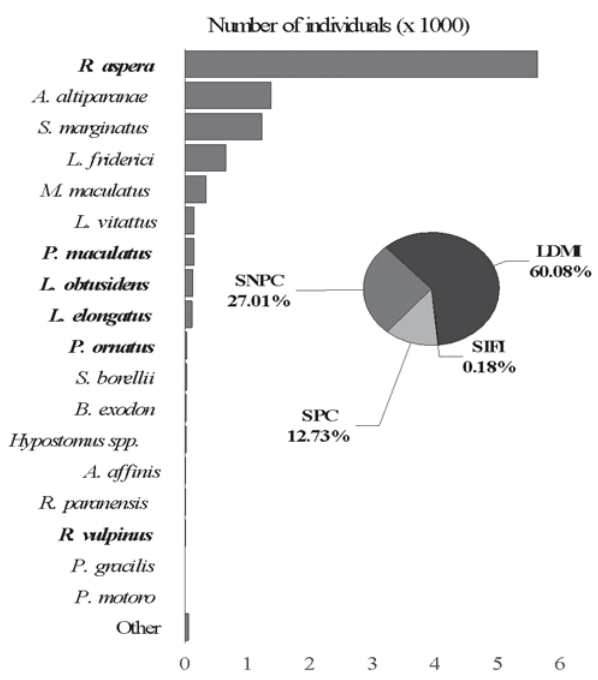
Fig. 3. Number of individuals of the main species and propor- tions of the life strategies (LDMI: long distance migratory species; SNPC: sedentary species that do not develop paren- tal care; SPC: sedentary species that develop parental care; SIFI: sedentary species with internal fertilization and internal development) sampled in both protocols conducted in the fish ladder located at Engenheiro Sergio Motta Dam (Migra- tory species are in bold).